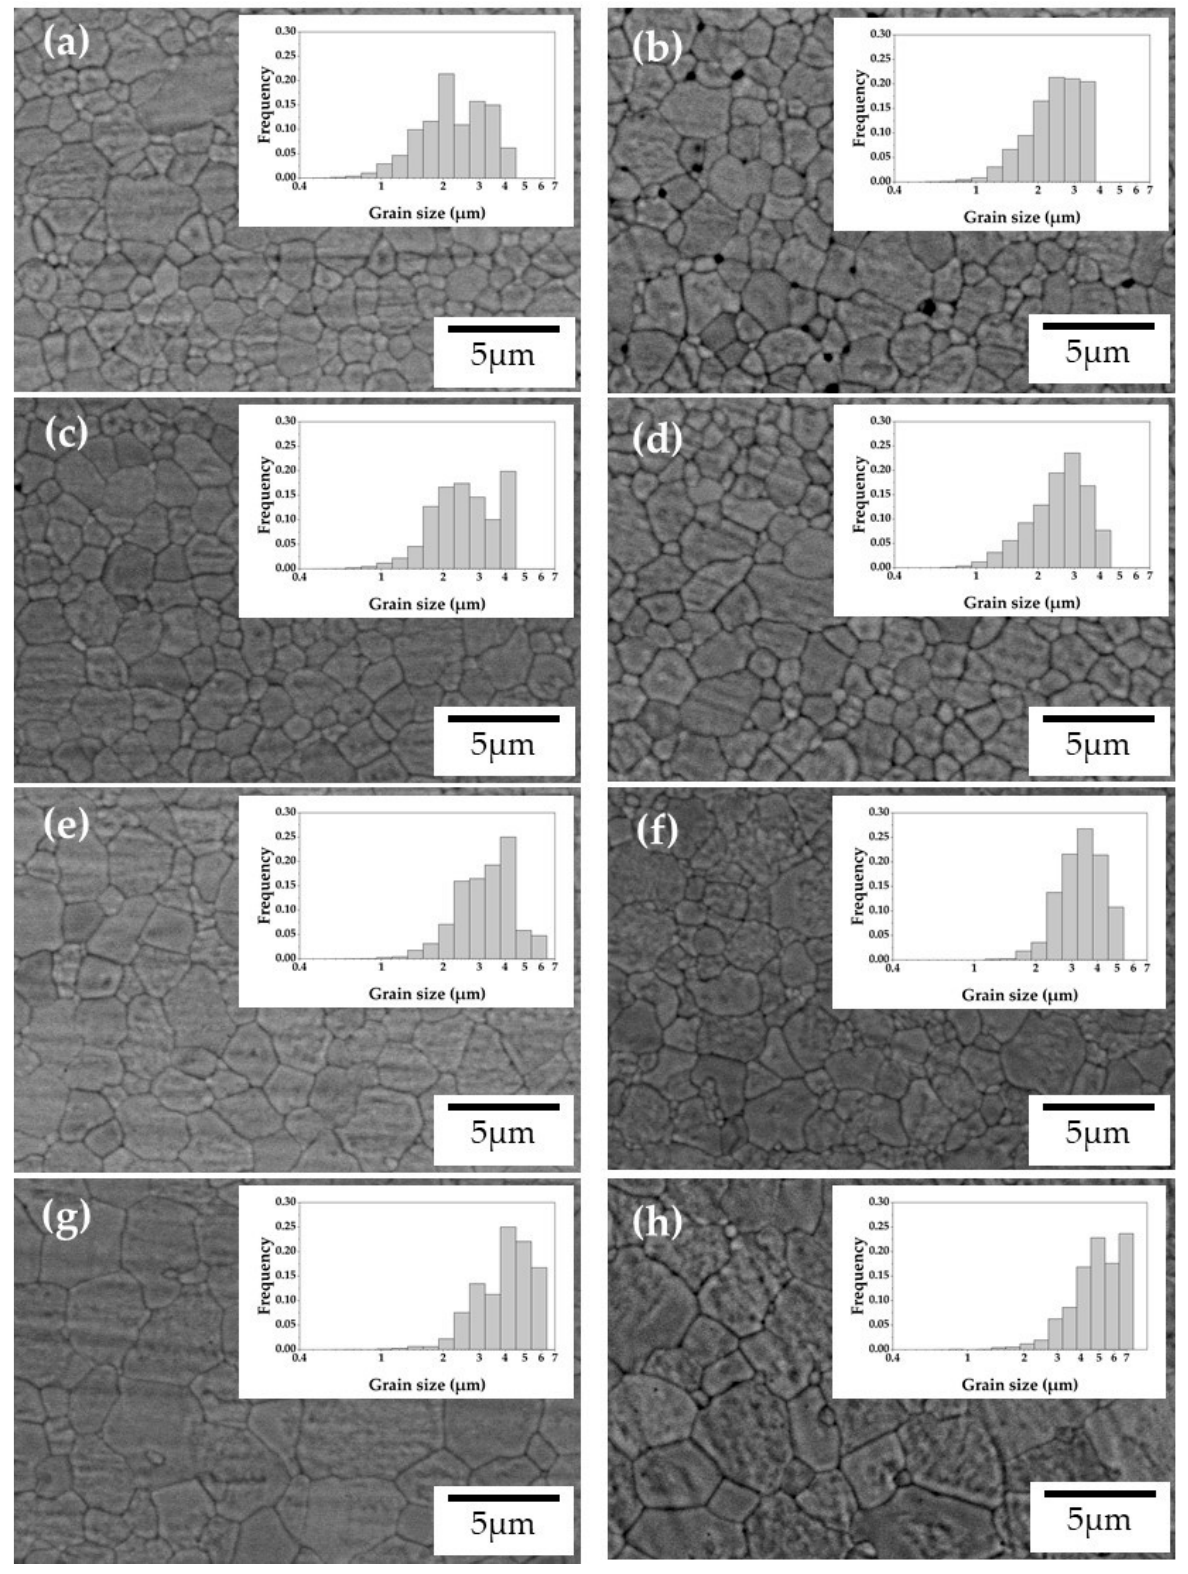
Figure 4. Scanning electron micrographs of: ( a , b ) Ga0–1.9 mm, 18 mm, ( c,d ) Ga1.5–1.9 mm, 18 mm, ( e , f ) Ga2.5–1.9 mm, 18 mm, ( g , h ) Ga5.0–1.9 mm, 18 mm.